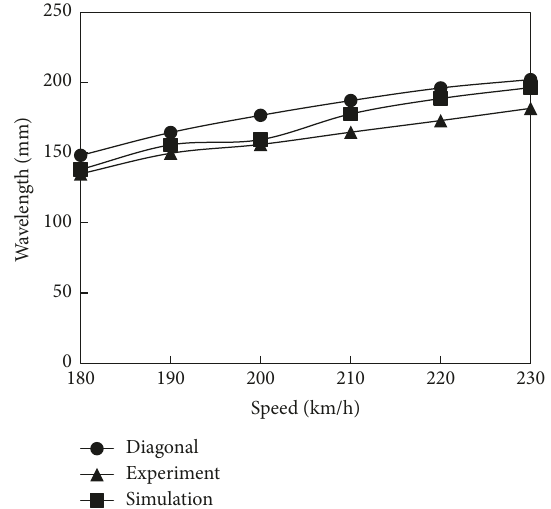
Figure 9: Comparison between theoretical calculation, simulation, and experiment results on wavelength of sidewall standing waves.